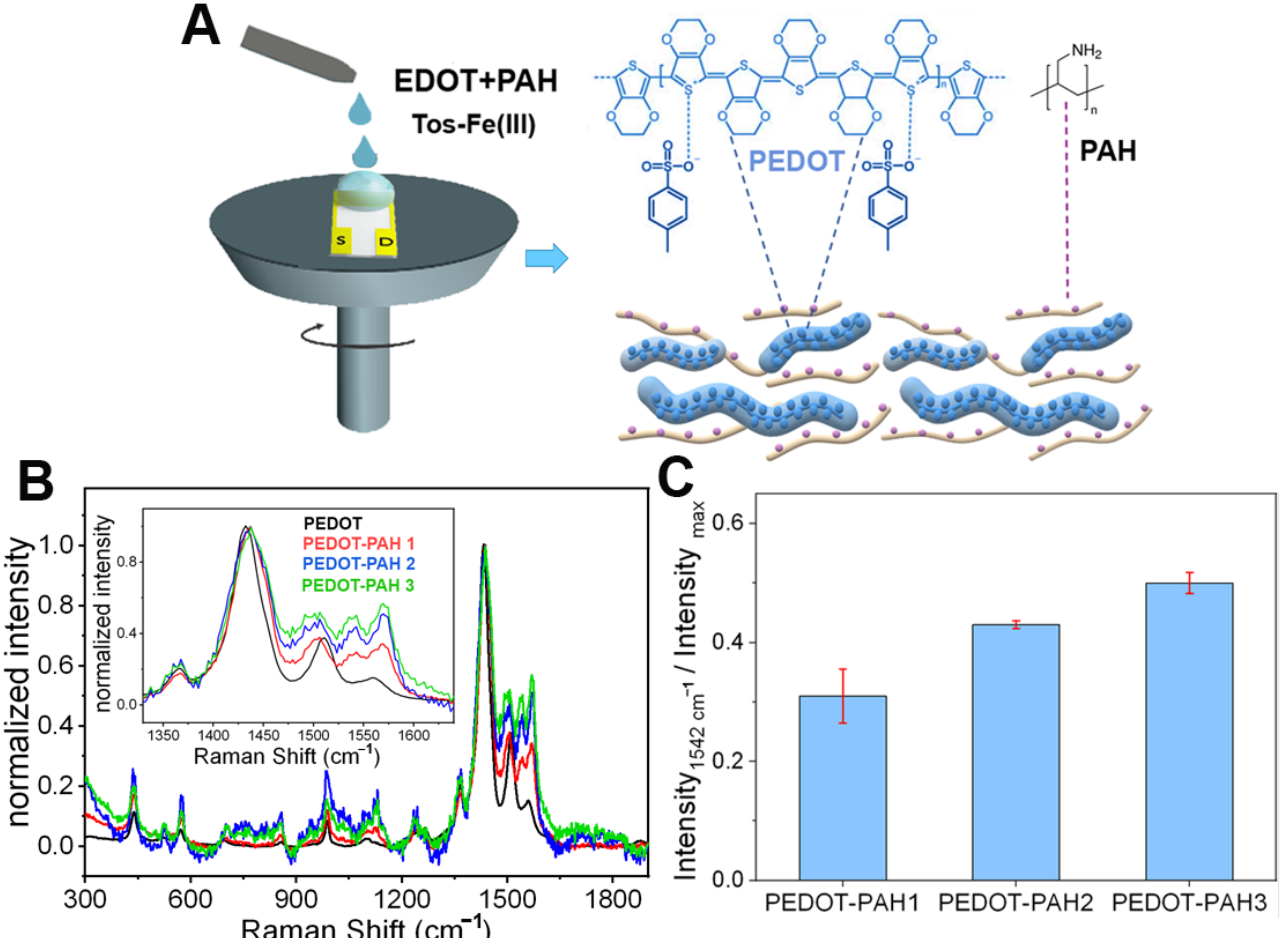
Figure 1. ( A ) Scheme of the synthesis of PEDOT-PAH films by spin coating. ( B ) Raman spectra of PEDOT (black), PEDOT-PAH 1 (red), PEDOT-PAH 2 (blue), and PEDOT-PAH 3 (green) films deposited on glass substrates. ( C ) Relative intensity of the Raman peak at 1541 cm − 1 to the maximum intensity (Intensity max ), corresponding to the peak at 1431 cm − 1 , for PEDOT-PAH blends of different compositions. Error bars correspond to SD ( n = 4).